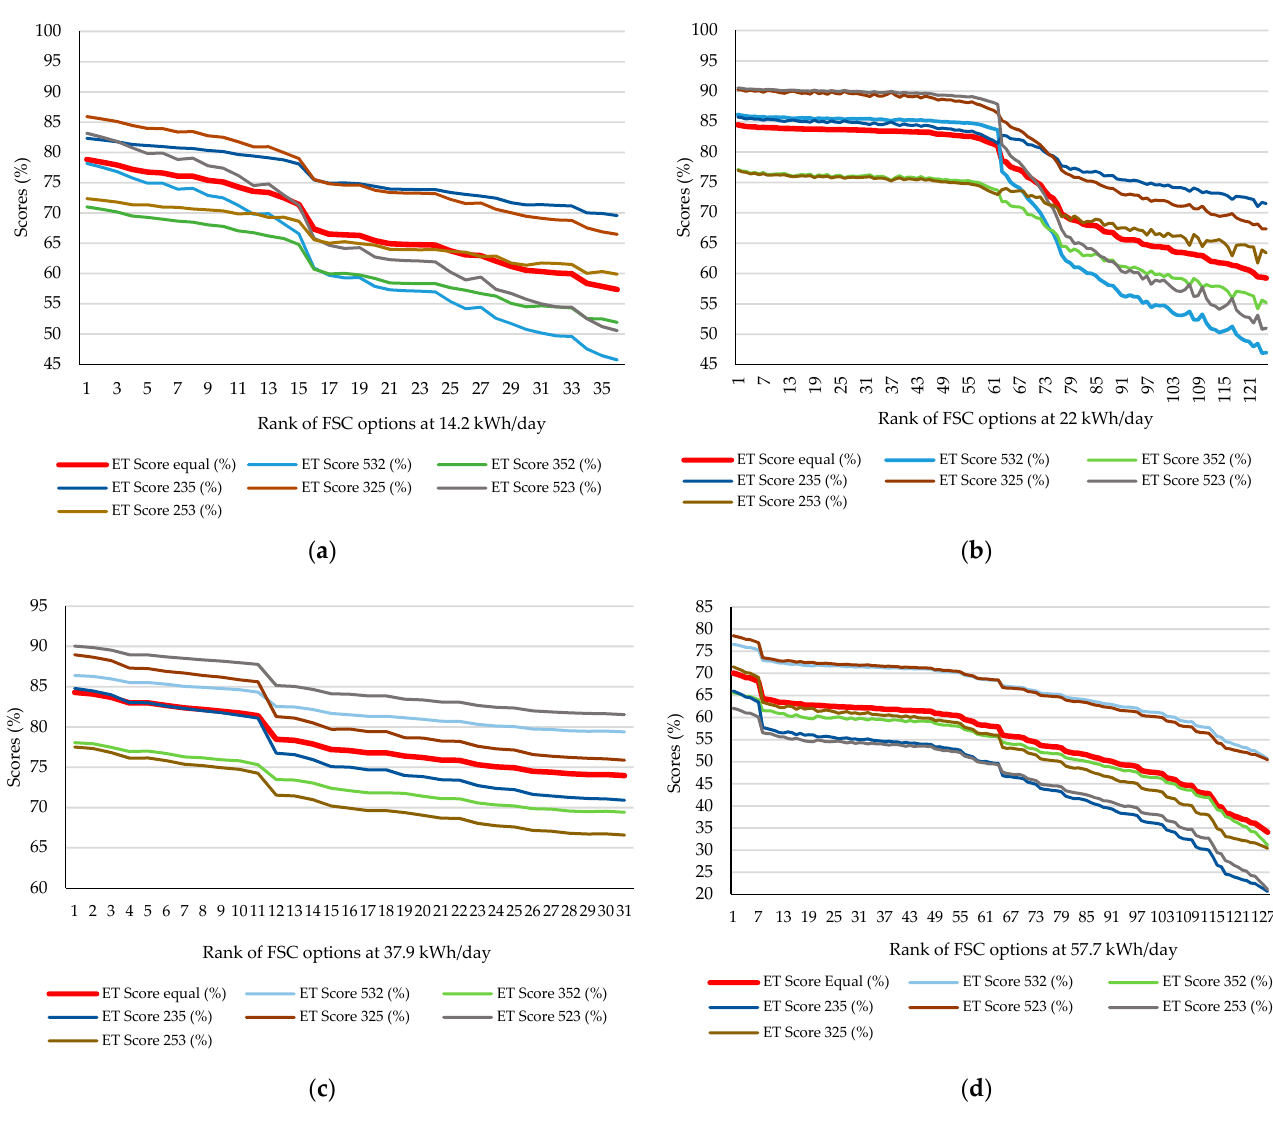
Figure 20. Effects of varying weight percentages on the OSC at ( a ) 14.2; ( b ) 22; ( c ) 37.9; and ( d ) 57.7 kWh/day.